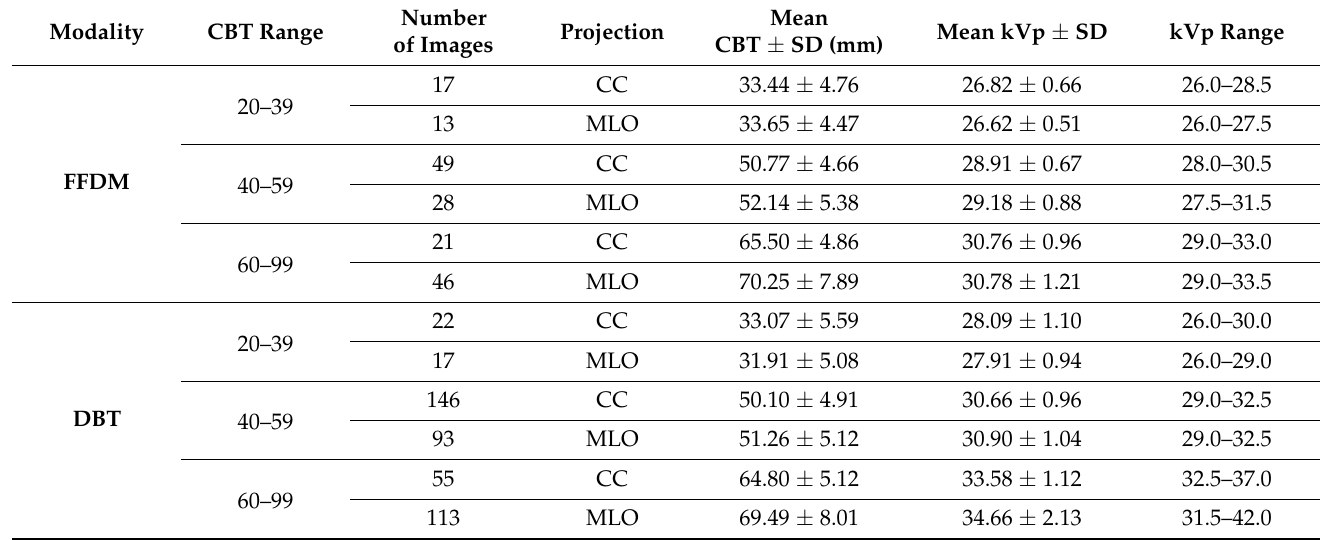
Table 3. Compressed breast thickness (CBT) range and exposure parameters used in full-field digital mammography (FFDM) and digital breast tomosynthesis